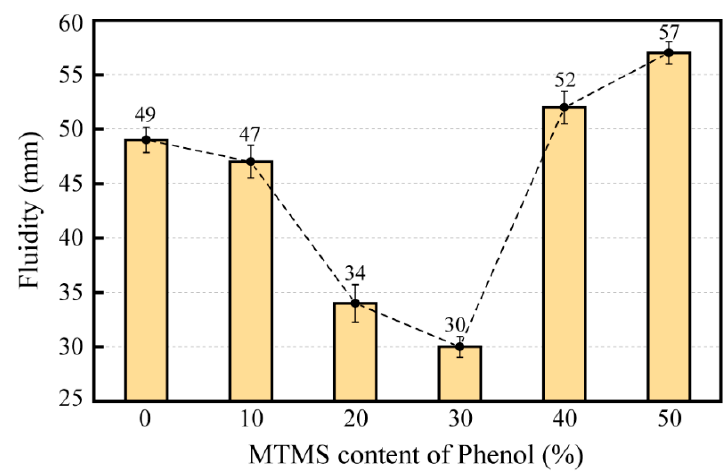
Figure 6. Fluidity of SMPR with different MTMS content of phenol.